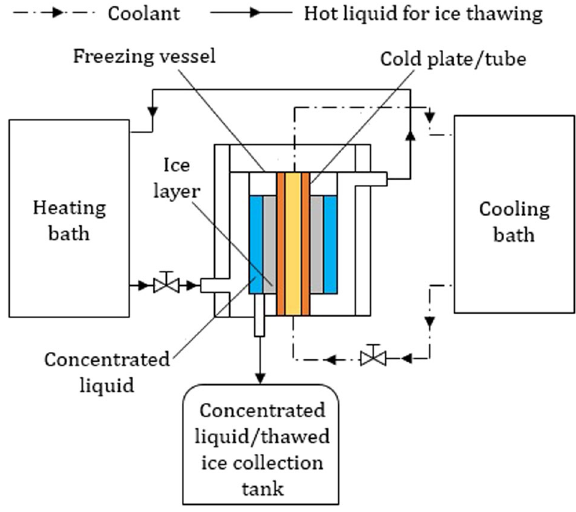
Fig. 6 Schematic of the block freeze-concentration process. The stagnant aqueous solution is completely frozen and then partially thawed.